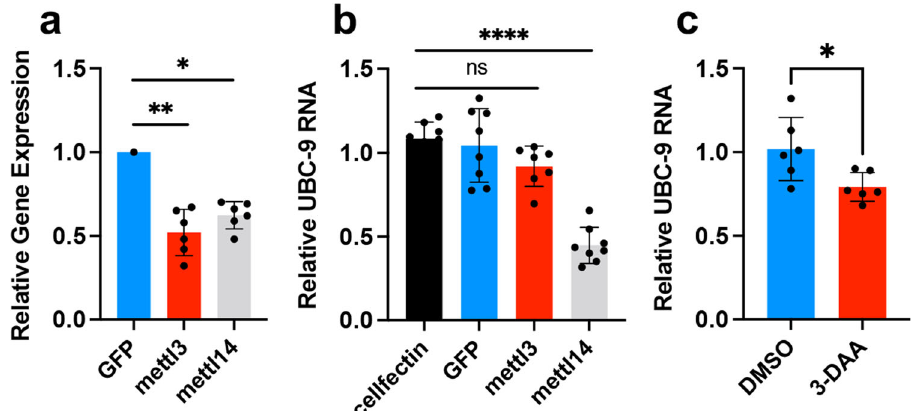
Fig. 8 Suppression of m 6 A modi fi cation reduces Ubc9 transcript levels. a Con fi rmation of silencing of METTL3 and METTL14 by RNAi in Aag2 cells. Control GFP was adjusted to one. * p < 0.05; ** p < 0.01 (one-way ANOVA with post hoc comparisons). b Decrease of Ubc9 expression by silencing m 6 A